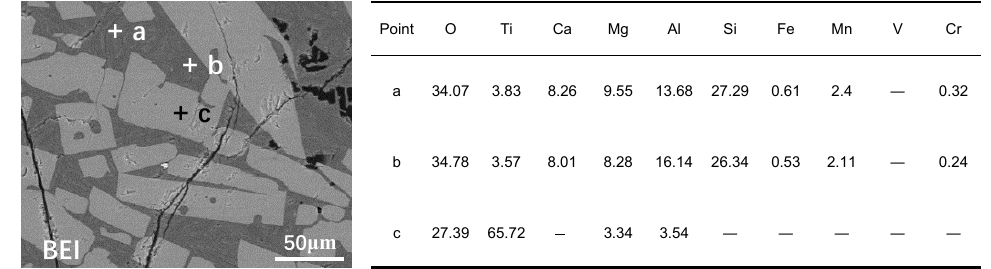
Figure 2. SEM microstructure and EDS analysis of Ti-bearing electric furnace slag (wt%).